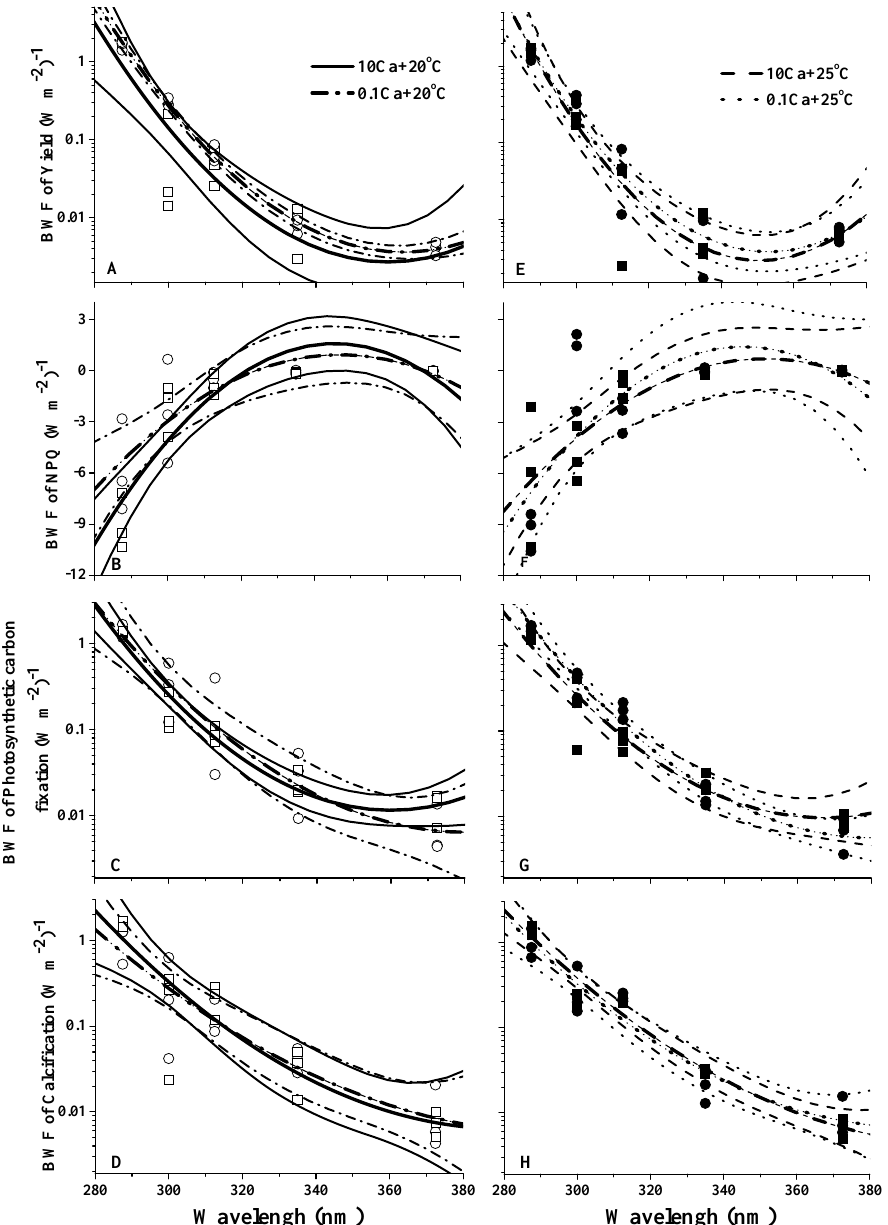
Fig. 7. Biological weighting functions (BWFs, in (Wm − 2 ) − 1 ) of Emiliania huxleyi : ( A and E ) effective photochemical quantum yield ( Y) ; ( B and F ) non photochemical quenching (NPQ); ( C and G ) photosynthetic carbon fixation and, ( D and H ) calcification rate of cells grown at HCa and LCa concentrations. The symbols represent the different combinations of Ca 2 + concentration and temperature: open squares: HCa cells at 20 ◦ C; filled squares: HCa cells at 25 ◦ C; open circles: LCa cells at 20 ◦ C and filled circles: LCa cells at 25 ◦